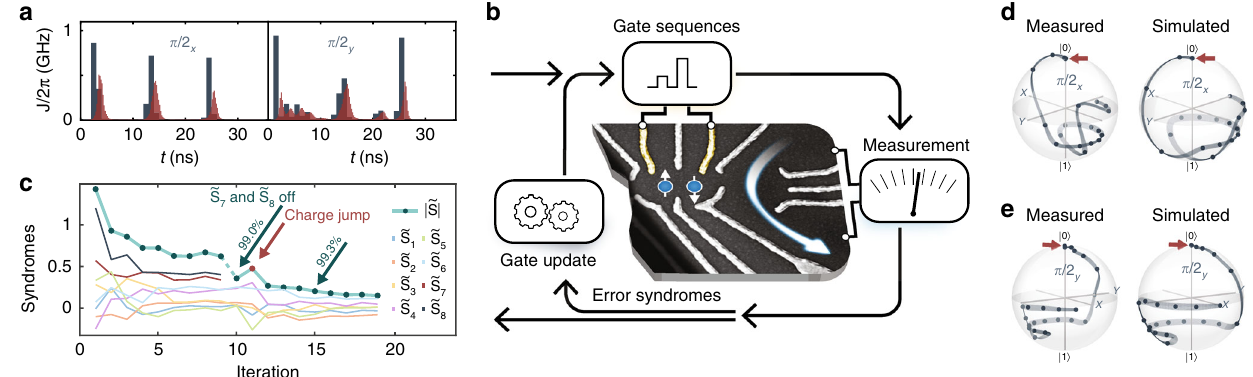
Fig. 2 Gate set calibration (GSC). a Numerical pulse optimization based on a realistic but inaccurate qubit model provides initial optimal control pulses (blue) for 36 ns long π /2 x and π /2 y gates. According to the model, the pulses shown in red are actually seen by the qubit. b Next, these pulses are optimized on the experiment using closed-loop feedback. 8 error syndromes ~ S i are extracted in each iteration by applying the gate sequences from Table 1. In order to remove gate errors, the syndromes ~ S are minimized by adjusting the pulse segments' amplitudes ϵ g . c Typically, GSC converges within 15 i j iterations and can recover from charge rearrangements in the quantum dot (indicated by a red dot, see Supplementary Note 16). Before iteration 1, the gate fi delity is typically so low that randomized benchmarking 33 (RB) can not be used to reliably extract the gate fi delity. This is remedied by scaling the pulses before the fi rst iteration, leading to an average Clifford gate fi delity between 63 and 70%. In this speci fi c calibration run, the feedback loop improved the fi delity of the gate set fi rst to 99.0 ± 0.1%, then to 99.3 ± 0.1% (after disabling the decoherence syndromes ~ S and ~ S ) and eventually to 99.50 ± 0.04% 7 8 (after adding a small correction of 0.05 to S M ). All of these fi delities are extracted using RB. d , e For a different gate set consisting of two 24 ns long pulses, we performed self-consistent state tomography 32 . After a few GSC iterations, the simulated Bloch sphere trajectories (right) can be reproduced in the experiment (left). A major portion of the remaining deviation can be attributed to concatenation errors with the measurement pulses, speci fi cally when states following large J pulses are determined.